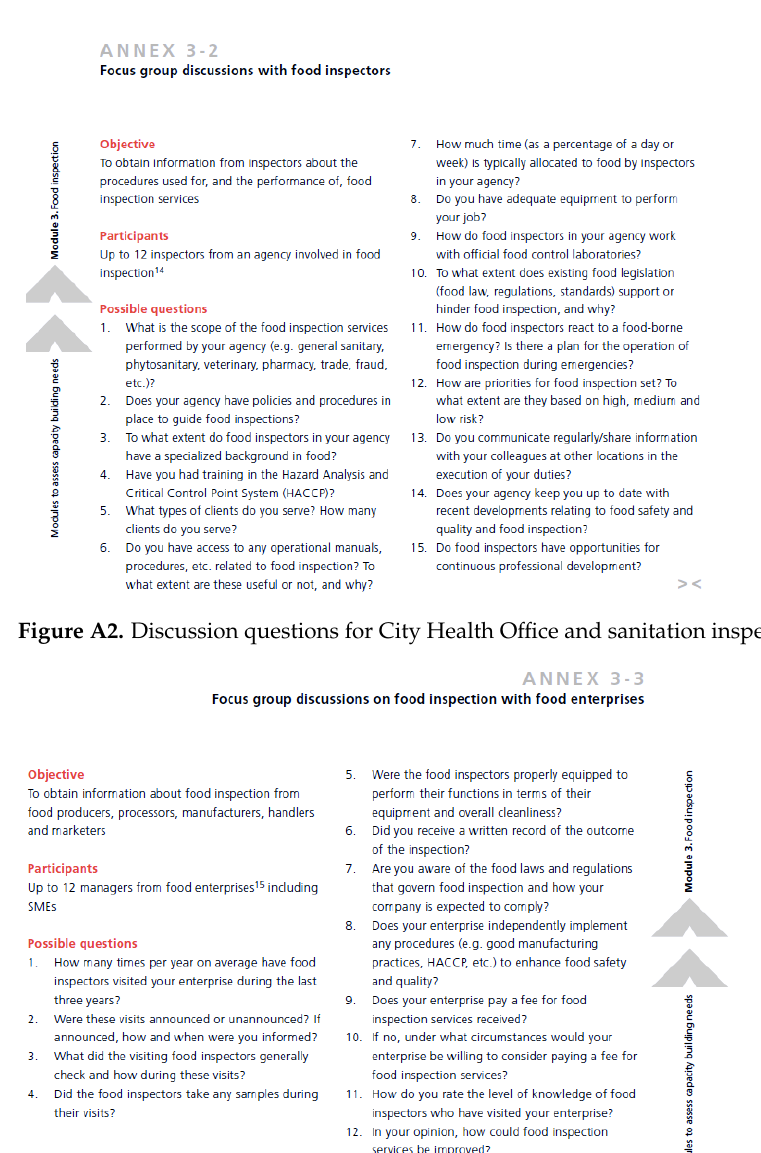
Figure A1. Agenda for discussion with national government officials.